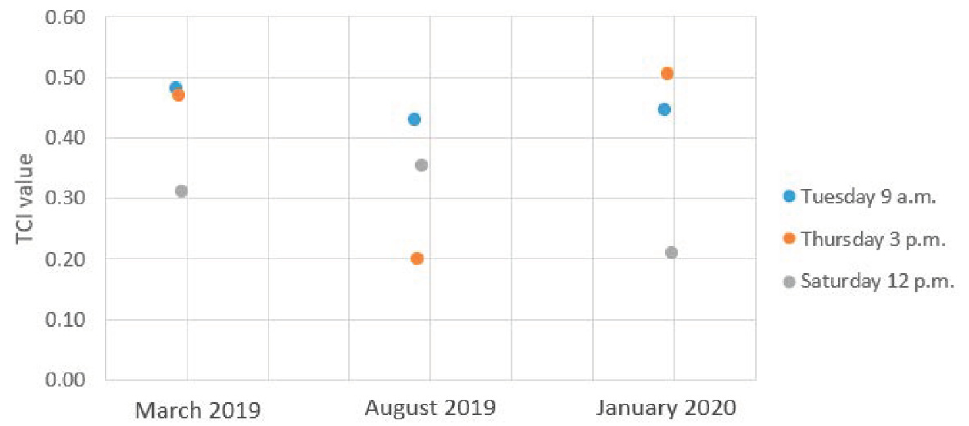
Table 8. Experiment results, reasoned per scenario. Figure 18. Results of the experiment—graph of TCI values per Figure 18. Results of the experiment—graph of TCI values per scenario.